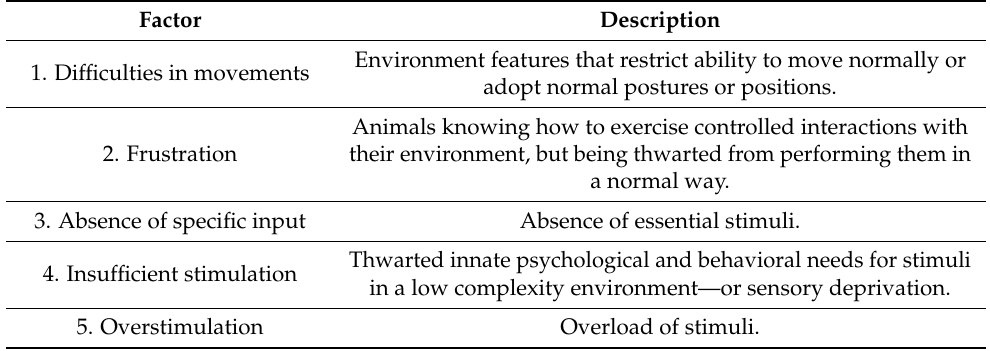
Table 1. Broom’s [21] five factors illustrating where control, or lack of it, may impact animal welfare.